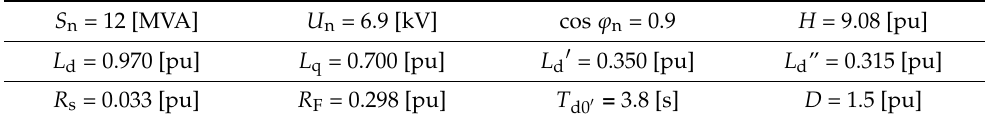
Table A2. Manufacturer’s data: hydro-type synchronous generator S n = 12 MVA.